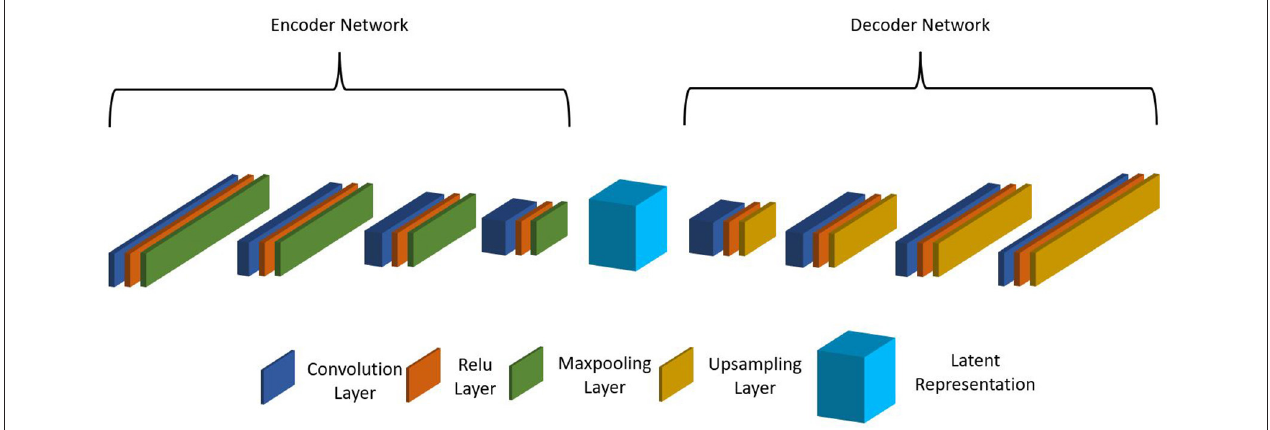
FIGURE 1 | Structure of proposed convolutional